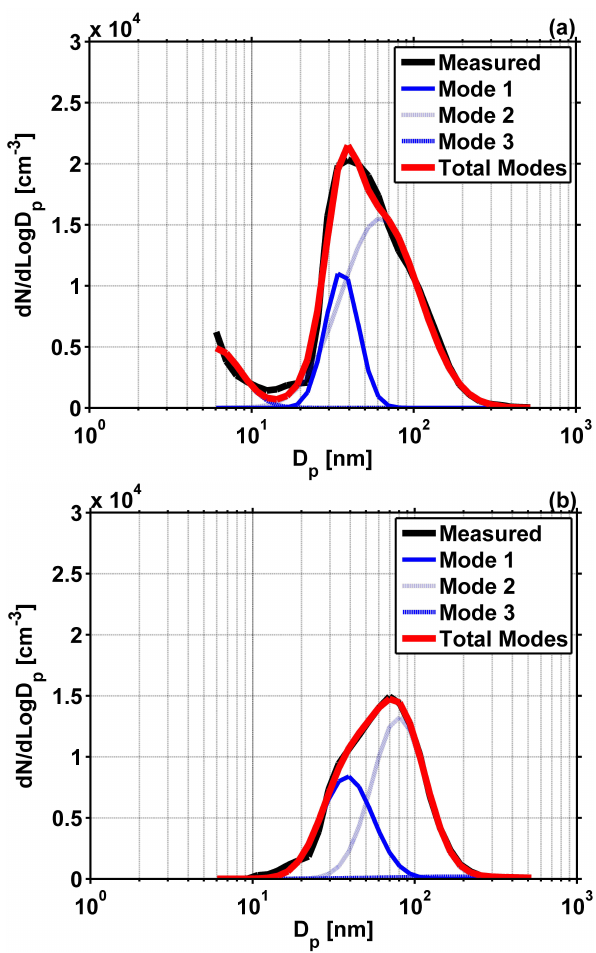
Fig. 2. Fit of the initial PSD to a three lognormal function using data measured by the FMPS at 00:00 LST for (a) an example A- event day (19 May) and (b) a non-event day (26